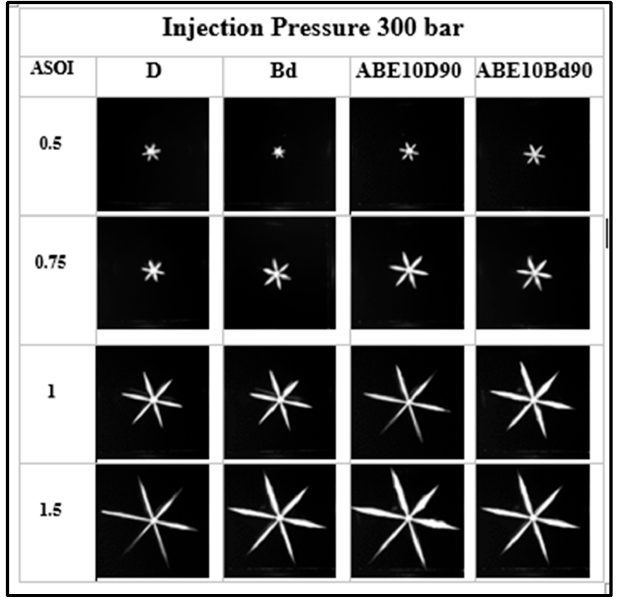
Figure 4. Spray comparison images of test blends.